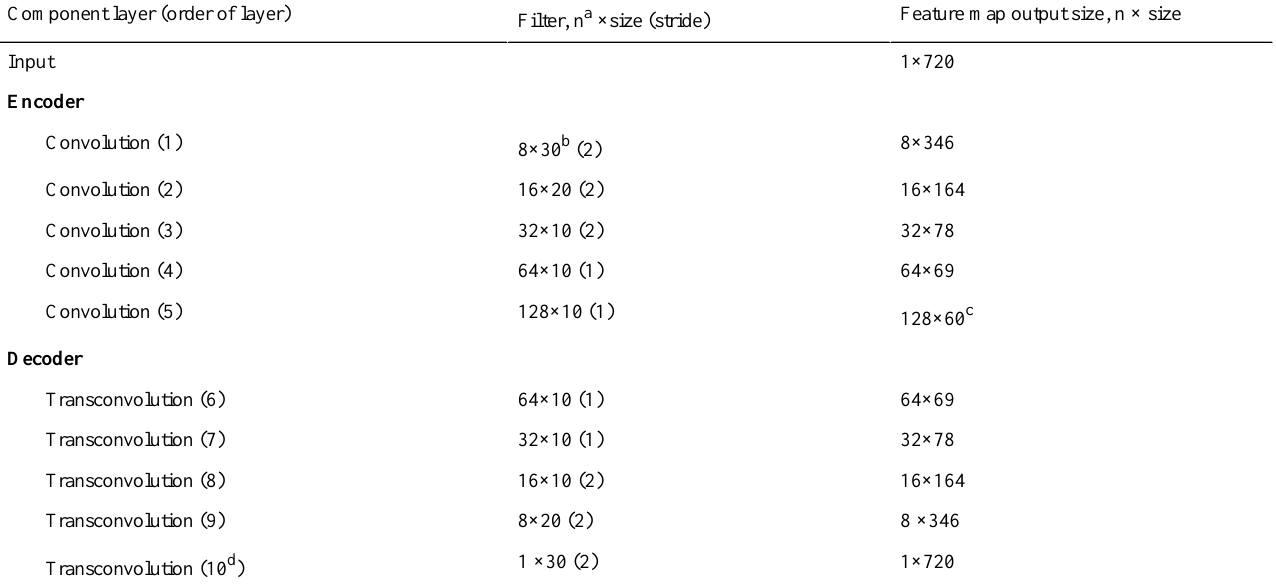
Table 3. Hyperparameter settings for the zero-inflated denoising convolutional